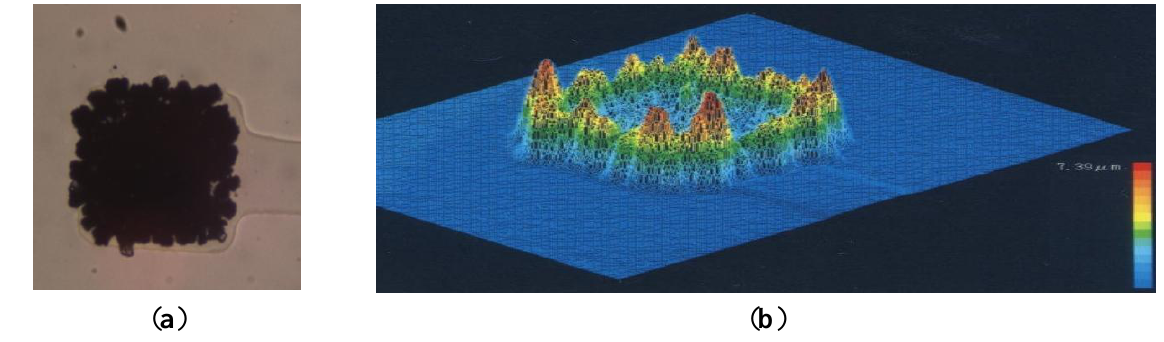
Figure 11. MED64 MEA: ( a ) a single 50 × 50 μm electrode showing copious platinum black deposition used to achieve a low impedance; ( b ) profile of a MED64 electrode showing tall (7.39 μm) dendritic growth, mainly at the periphery of the electrode (from [105]).